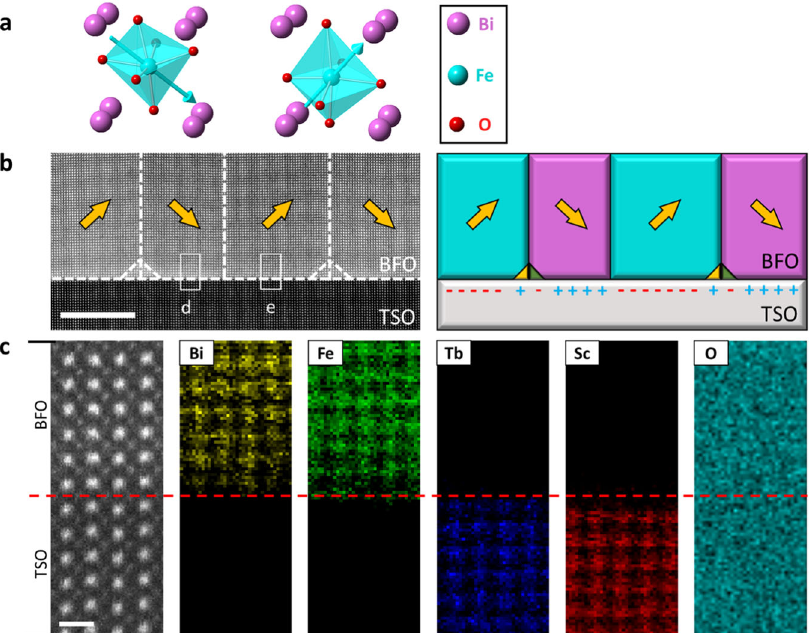
Fig. 1 STEM and atomic-resolution EDS. a Atomic models of the pseudocubic structure of BFO. Polarizations are shown by cyan arrow. b Low-magni fi cation HAADF image of a cross-section of BFO/TSO heterostructure and the corresponding schematic of the domain arrays. In HAADF image the yellow arrows indicate polarization directions, and dashed lines indicate the positions of 109 (cid:1) domain walls, triangle domains, and BFO/TSO interface. In the schematic “ + ” and “ − ” indicate positive and negative bound charges that are produced by the alternating polarization directions. Scale bar, 10 nm. c An atomically resolved HAADF image and corresponding EDS mappings of the BFO/TSO interface. White rectangles d and e in Fig. 1b are the regions where Fig. 2d, a were collected from. Scale bar, 0.5